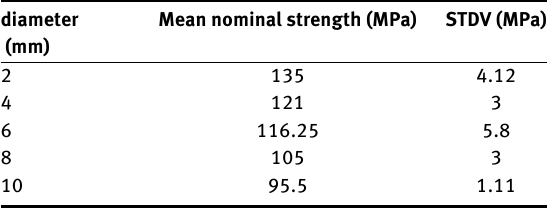
Table 3. Notch strength of open hole tensile test.